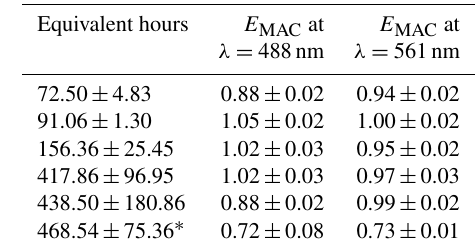
(cid:113) oxidation